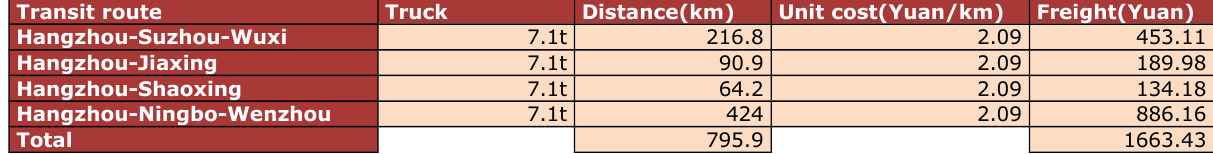
Table 6. Final Scheduling Program and